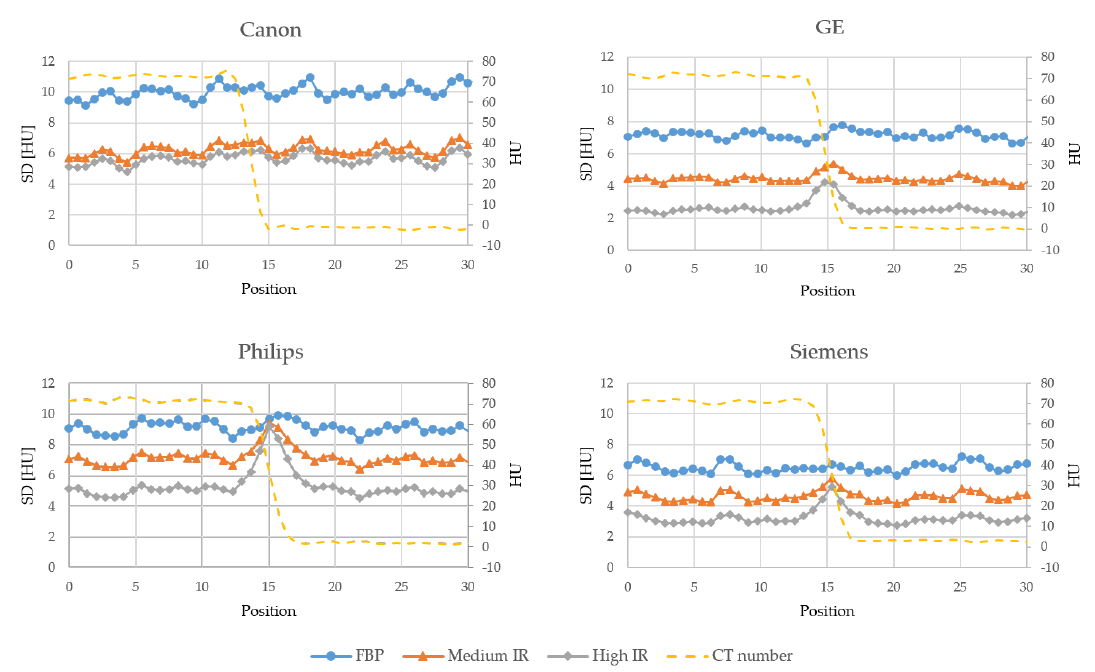
Figure 4. Edge profiles showing the standard deviation (SD) measured over the 70 HU edge in the noise maps reconstructed with FBP, a medium level of IR and a high level of IR for each vendor. The dashed line shows the average CT number in the FBP